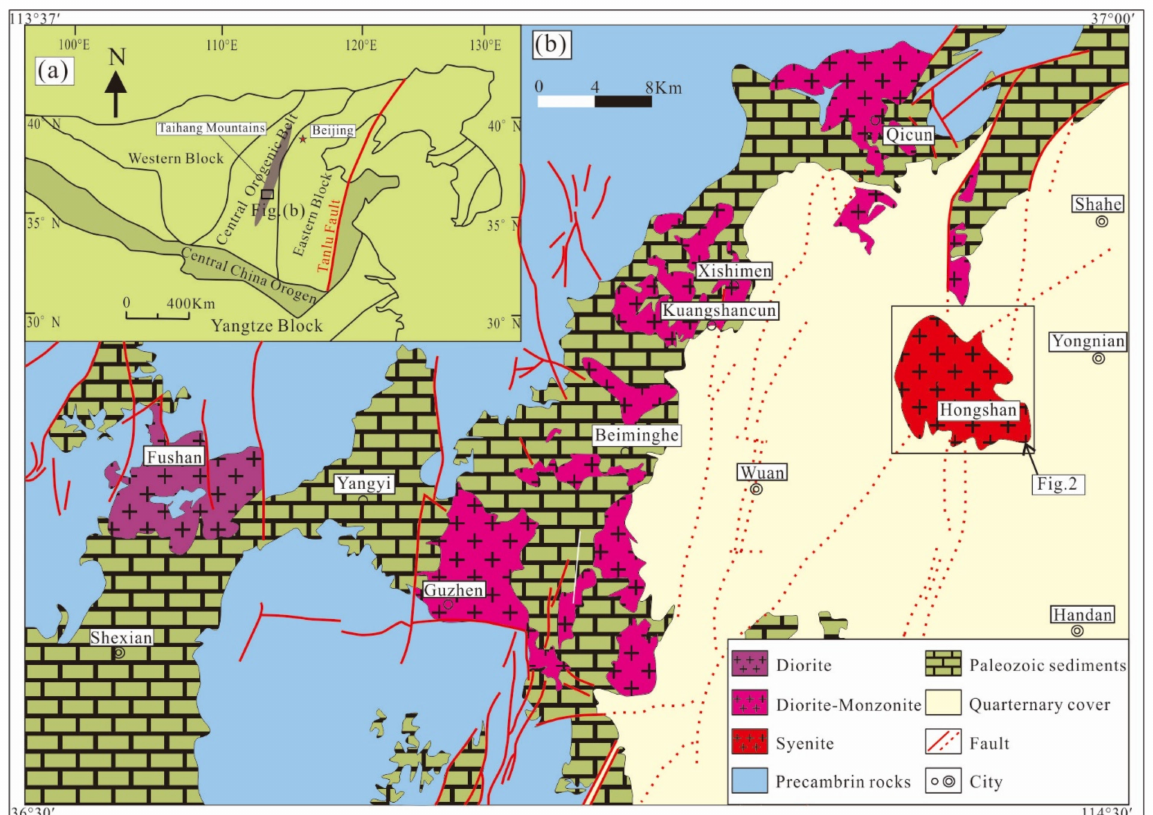
Figure 1. ( a ) Simplified geological map showing the major tectonic units of the North China Craton(modified after [1]); ( b ) Geological map showing the distribution of the intrusive complexes in Handan district (modified after